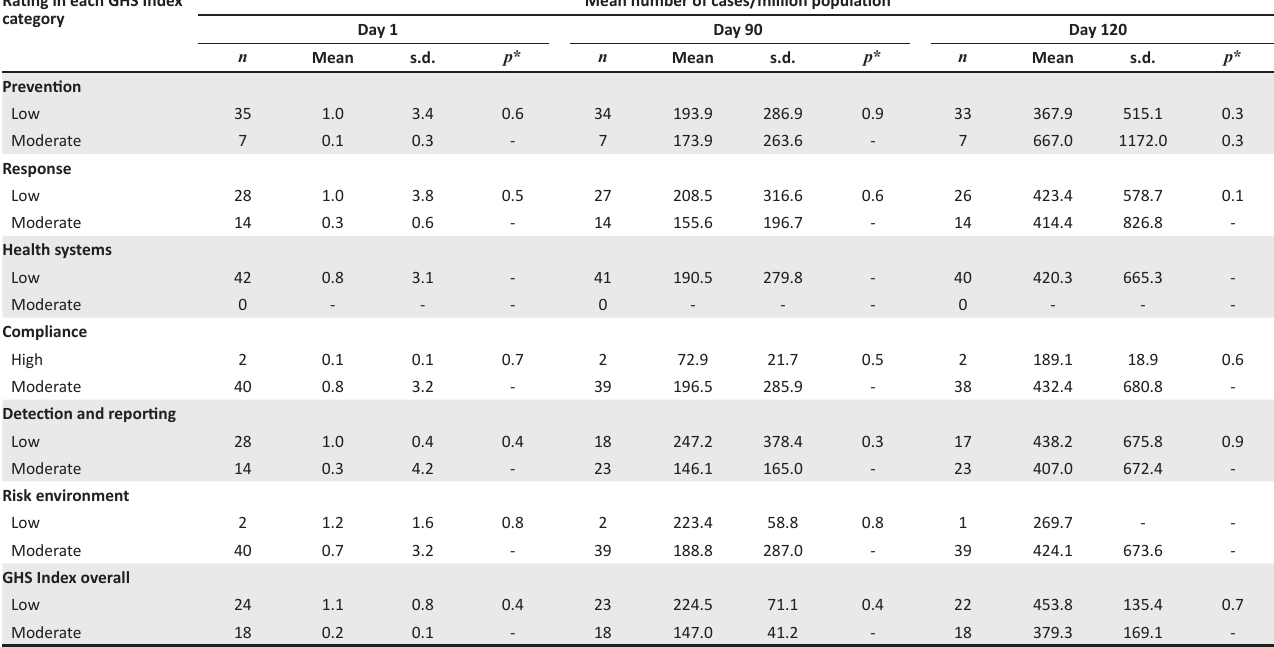
TABLE 5: Mean number of cases per million population and the performance of the 42 WHO African Region countries in the GHS Index evaluations conducted in 2019. Rating in each GHS Index category